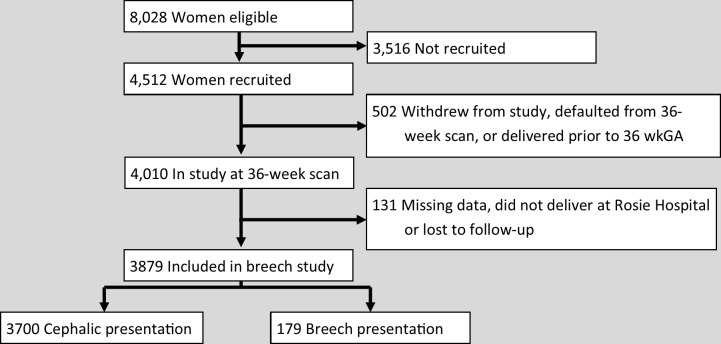
Patient recruitment.Schedule of patient recruitment in the POP study shown by foetal presentation. POP, Pregnancy Outcome Prediction.